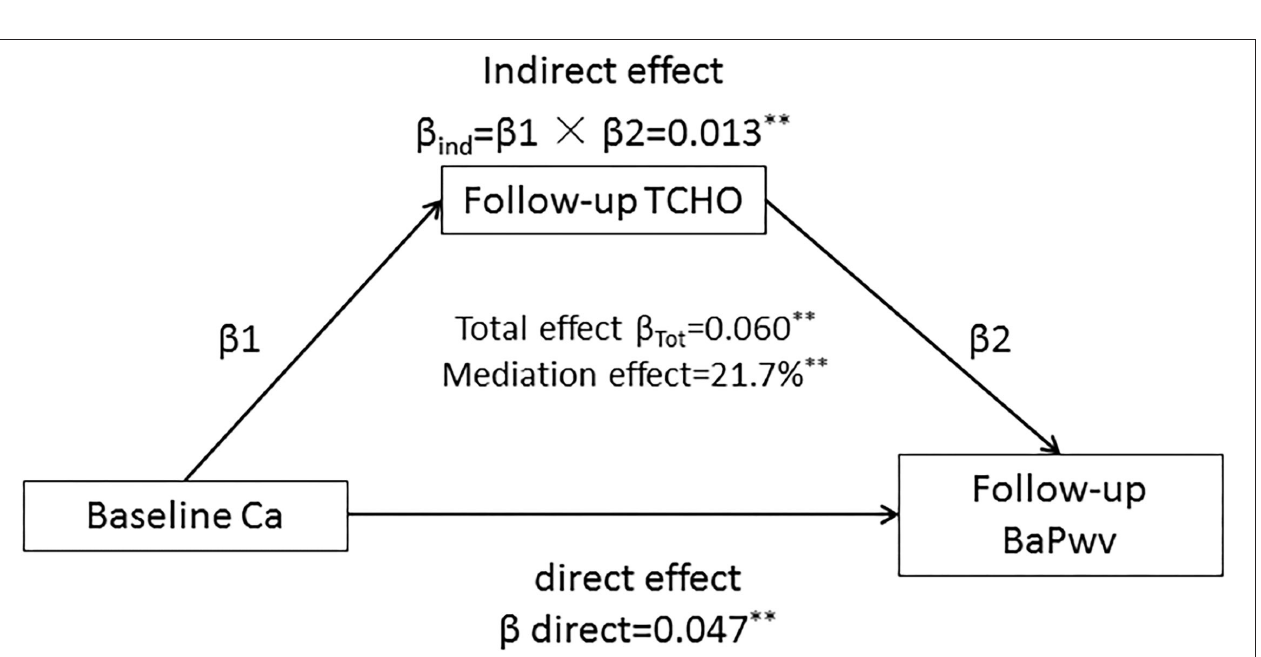
FIGURE 4 | The mediation effect of follow-up cholesterol on the baseline serum calcium with future value of baPWV association with adjustment for the covariates (covariates included age, sex, BMI, smoking, alcohol consumption, regular exercise, marriage, caloric intake, family history of CVD, TG, HDL-C, LDL-C, and drug use for hypertension or dyslipidemia) in the total sample ( N = 3,292). The data were standardized regression coefficients; *** P < 0.001, ** P < 0.01 for coefficients being different from 0.